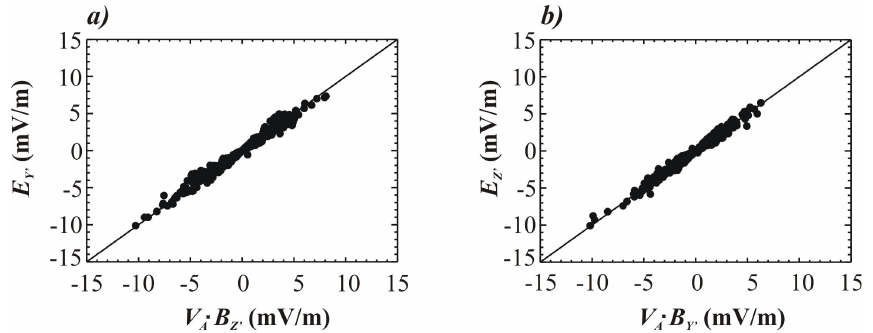
Fig. 8. (a) Scatterplot of δEY 0 versus V A · δBZ 0 measured during the intervals of PSBL crossings, when the strongest correlation between EY 0 and BZ 0 components was observed. (b) Scatterplot of δEZ 0 versus V A · δBY 0 is presented for the PSBL crossings in which the highest correlations between EZ 0 and BY 0 components were registered.